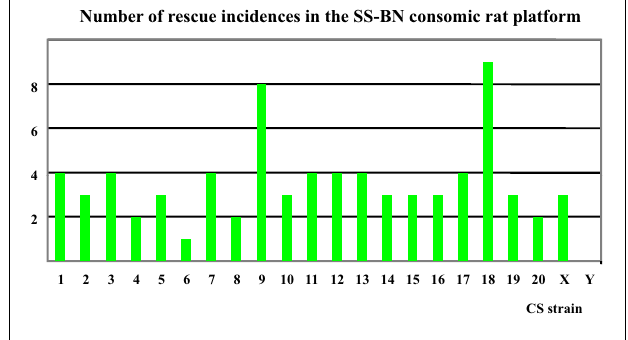
FIGURE 4 | Number of “rescue” incidences in the SS-BN consomic platform. SS-9 BN and SS-18 BN showed the highest number of “rescues incidences, and were therefore defined as hypoxia-resistant CS strains. In contrast, SS-6 BN and SS-Y BN were termed hypoxia-susceptible strains.